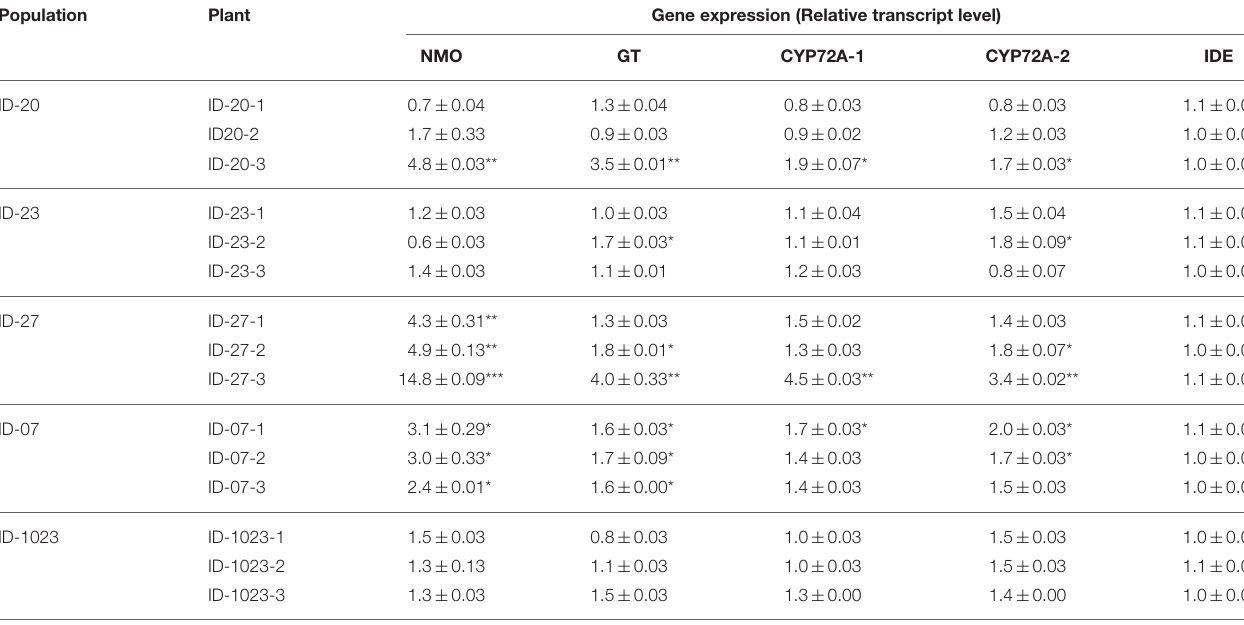
TABLE 5 | Expression of herbicide metabolism genes in selected populations of Lolium multiflorum. Population